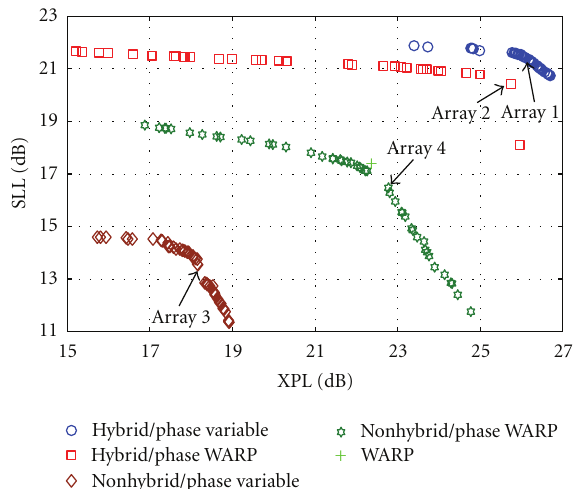
Figure 3: Resulted Pareto front of hybrid and nonhybrid, variable phase and WARP phase compared to WARP method result.